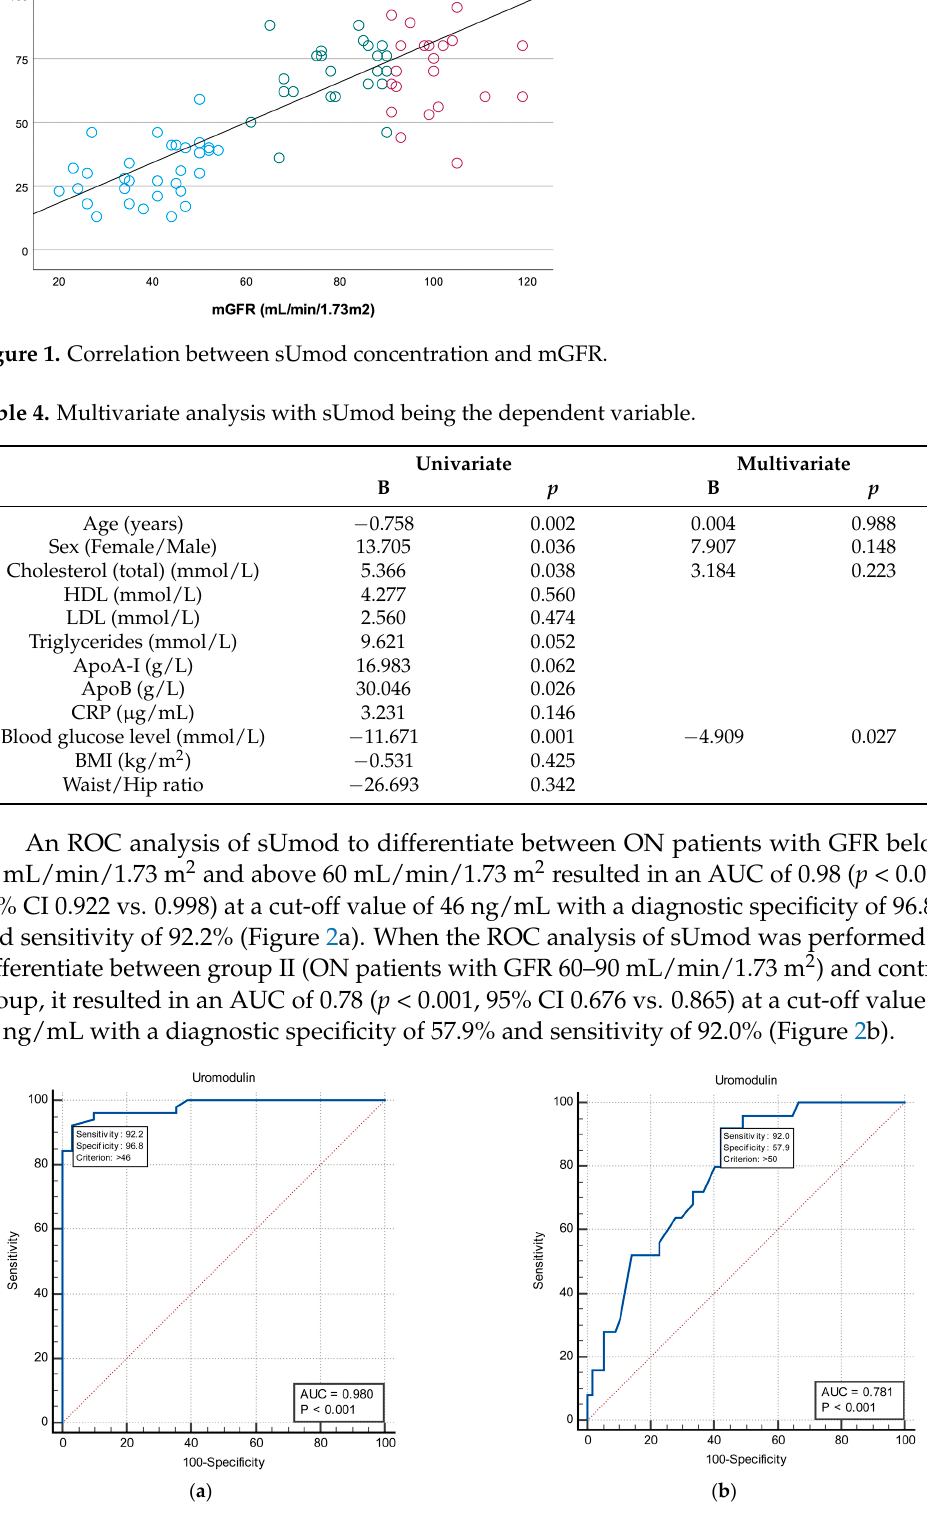
Figure 2. ROC analyses for the predictive value of sUmod for mGFR <60 mL/min/1.73 m 2 ( a ), and mGFR <90 mL/min/1.73 m 2 ( b ).